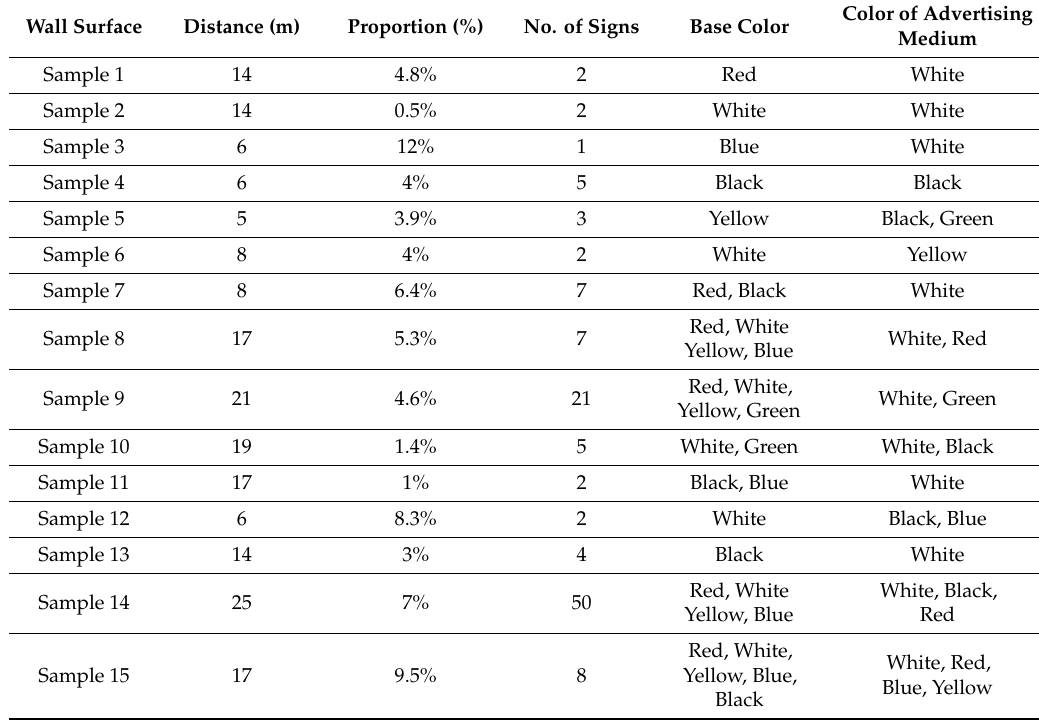
Table 1. Analysis of landscape samples of wall advertising